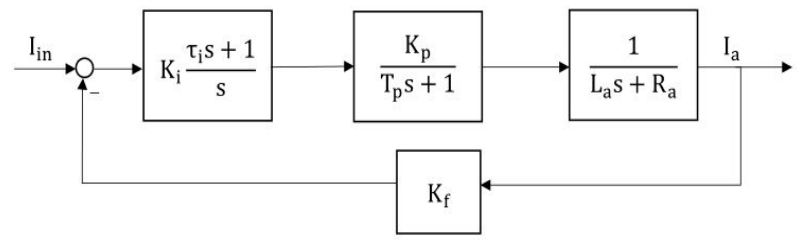
Figure 3. Current loop control block